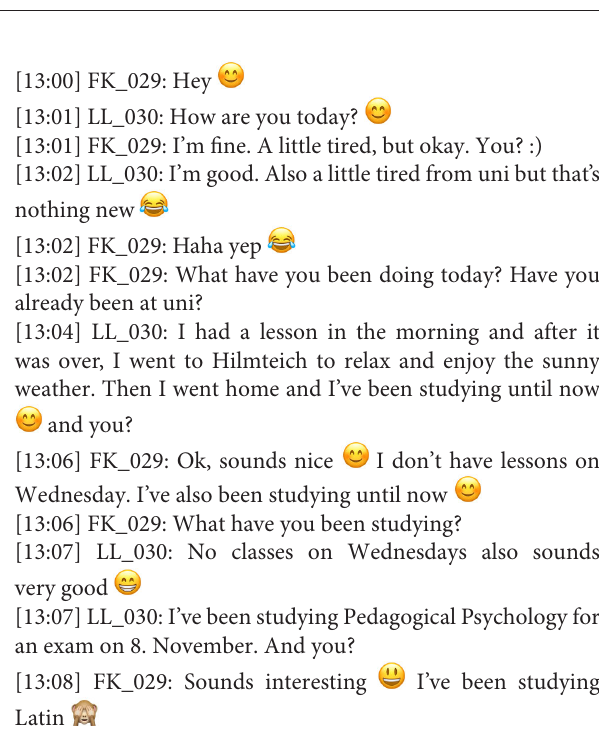
FIGURE 3 | Non-leaders’ emoji use according to